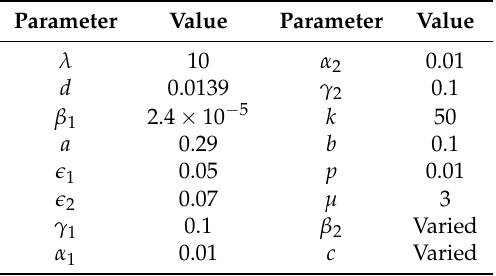
Table 1. List of parameters and their values used in numerical